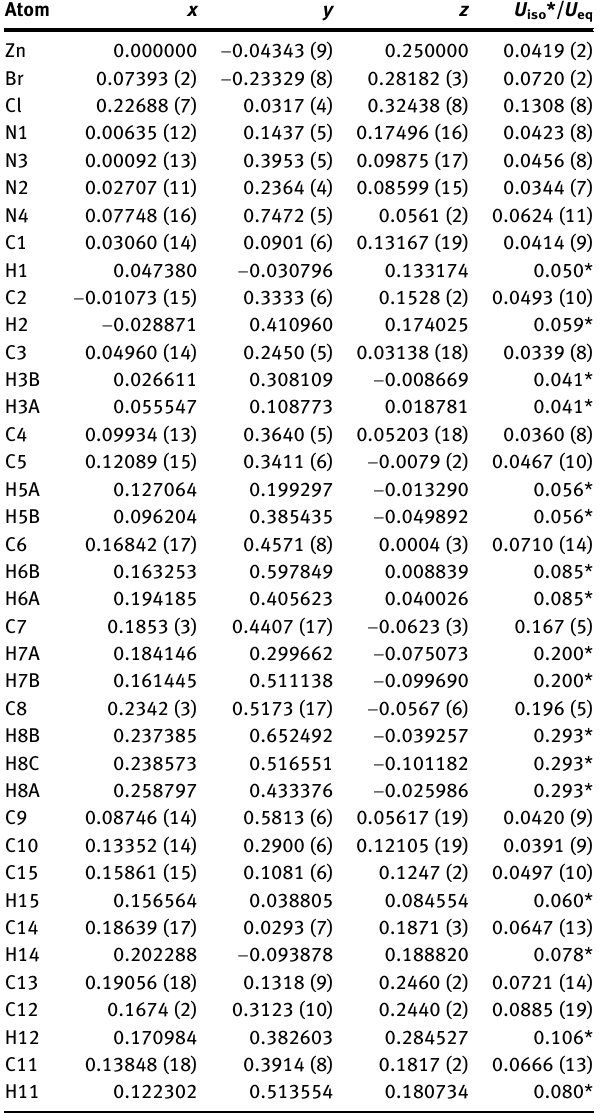
Table  : Fractional atomic coordinates and isotropic or equivalent isotropic displacement parameters (Å 